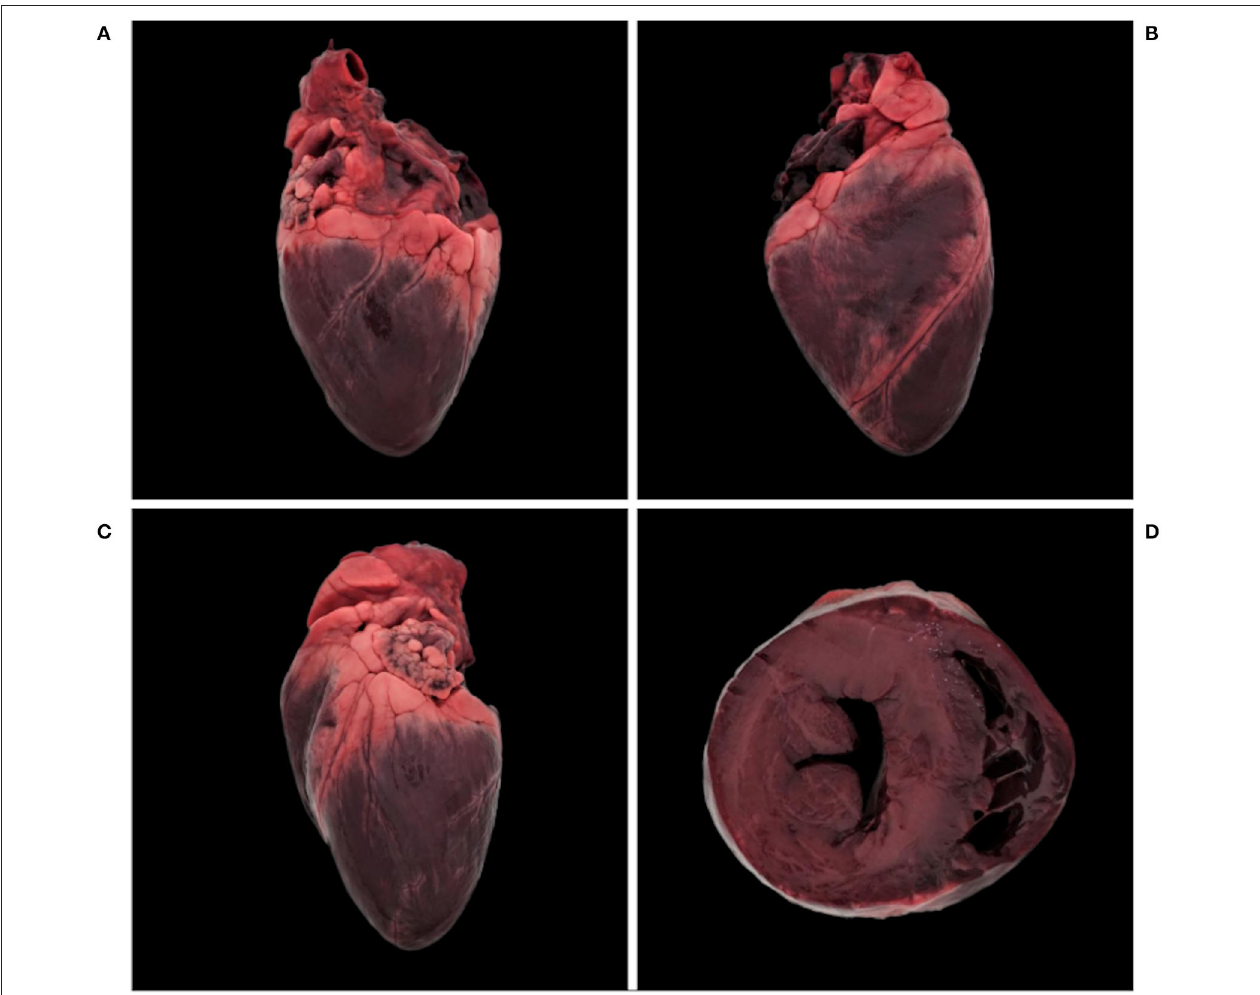
FIGURE 1 | Normal heart, Eurasian lynx ( Lynx lynx carpathicus ); (A) right lateral view, (B) diaphragmatic view, (C) left lateral view, and (D) cross-section. Dark coloration is a freezing artifact.